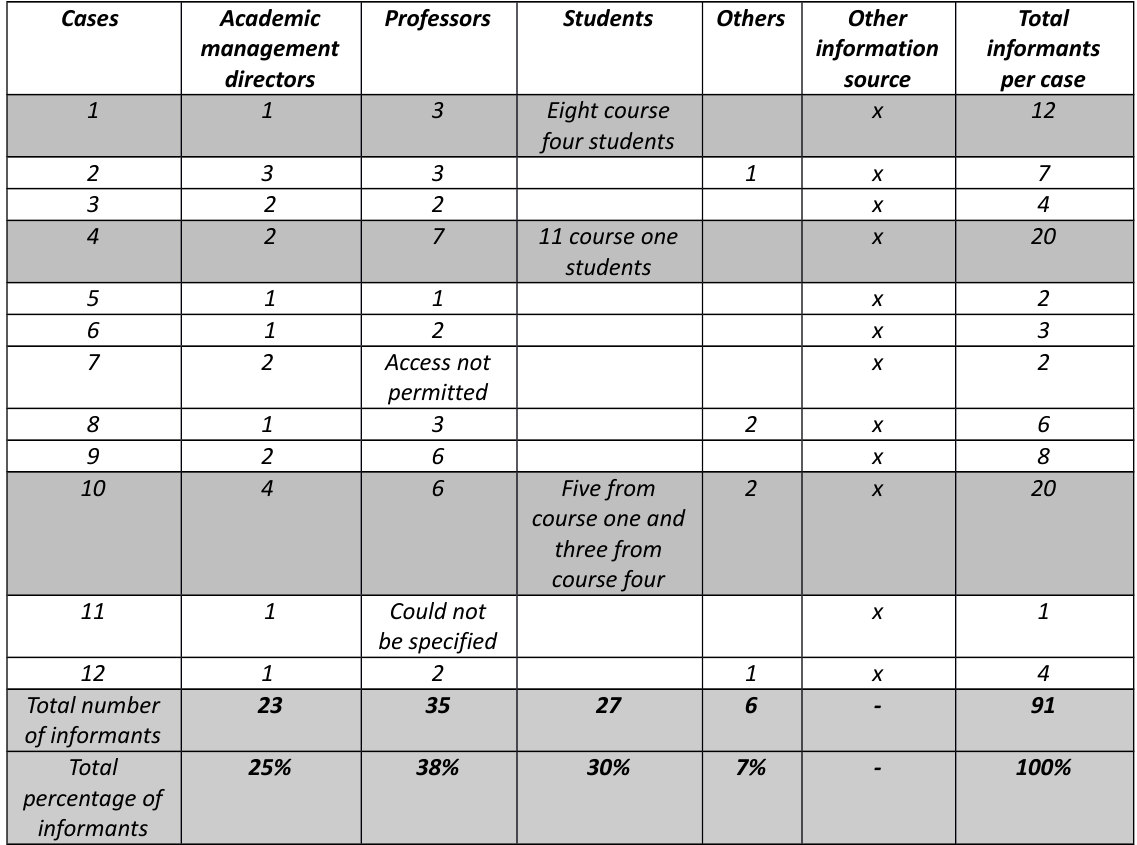
Table 2. Distribution of the informants who participated in the case